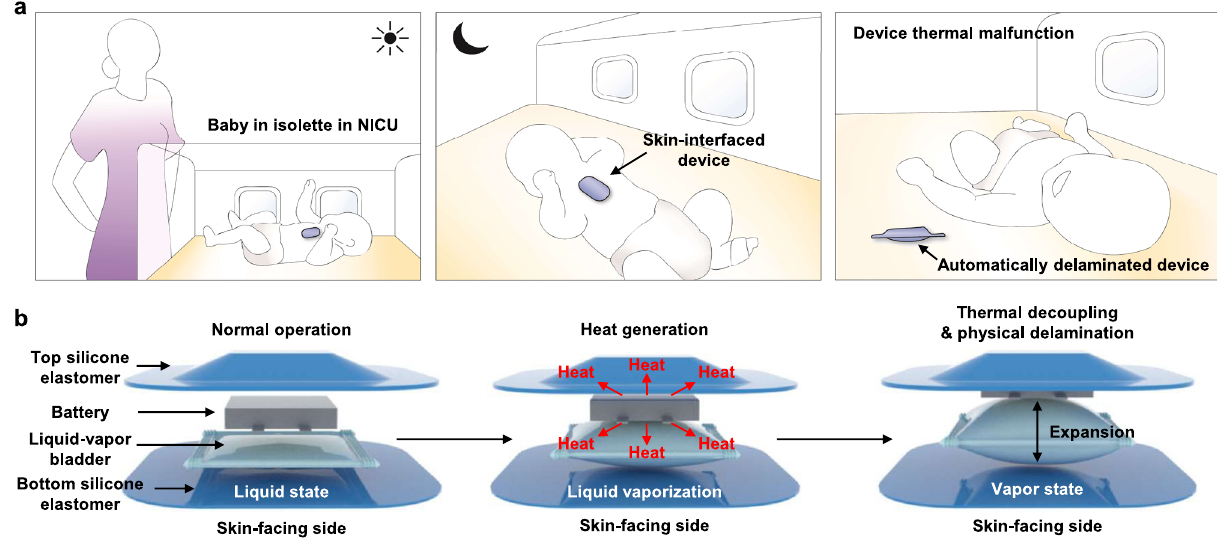
Fig. 1 | Automatic thermal safety system to protect the skin from overheating of a skin-interfaced, wireless electronic device. a Illustrations of a baby in an isolette in a NICU with a device mounted on the chest. Heating associated with device malfunction automatically activates the safety system to thermally isolate